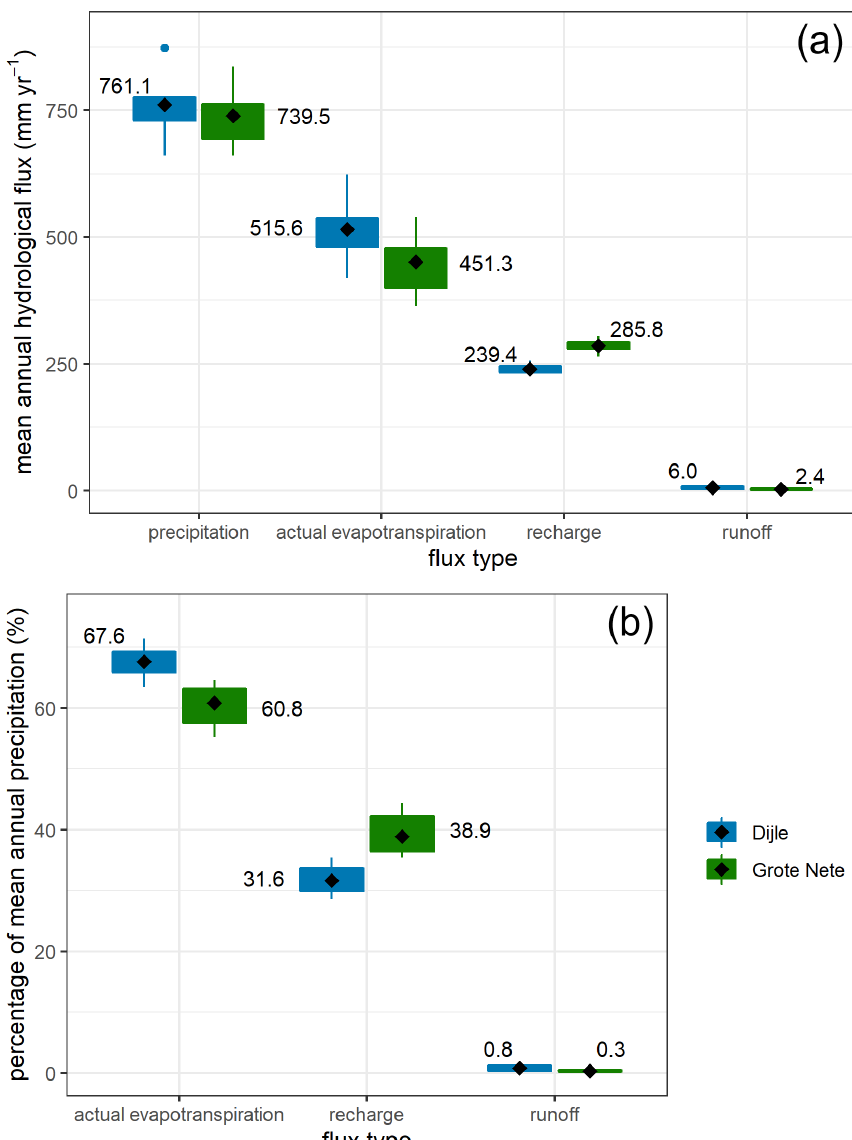
Figure A5. (a) Mean annual hydrological fluxes (mmyr − 1 ) over the Dijle and Grote Nete basins for each combination of climate and land cover scenario ( n = 30). (b) Relative mean annual hydrological fluxes as a percentage of the total annual precipitation over the Dijle and Grote Nete basins. The mean value is indicated by a black diamond. The numbers correspond to the mean value over all scenario combinations. The box indicates all values within the 25th to 75th percentile range, and the whiskers represent all values within the range from the 25th percentile to 1.5 times the interquartile range to the 75th percentile plus 1.5 times the interquartile range. Coloured dots represent all other values outside this